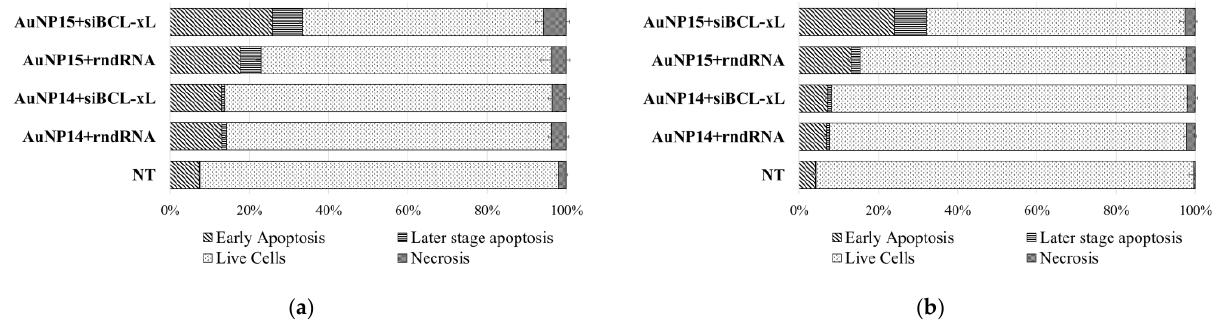
Figure 6. Distribution of ( a ) HL-60 and ( b ) CEM-SS cells by types of cell death among the entire population of cells after 48 h incubation. AuNP concentrations correspond to optimal delivery concentrations based on previous calculations (100 µg/mL for AuNP13; 25 µg/mL for AuNP14; 10 µg/mL for AuNP15). Data obtained by flow cytometry. In each repeat at least 50,000 events were collected and analyzed.